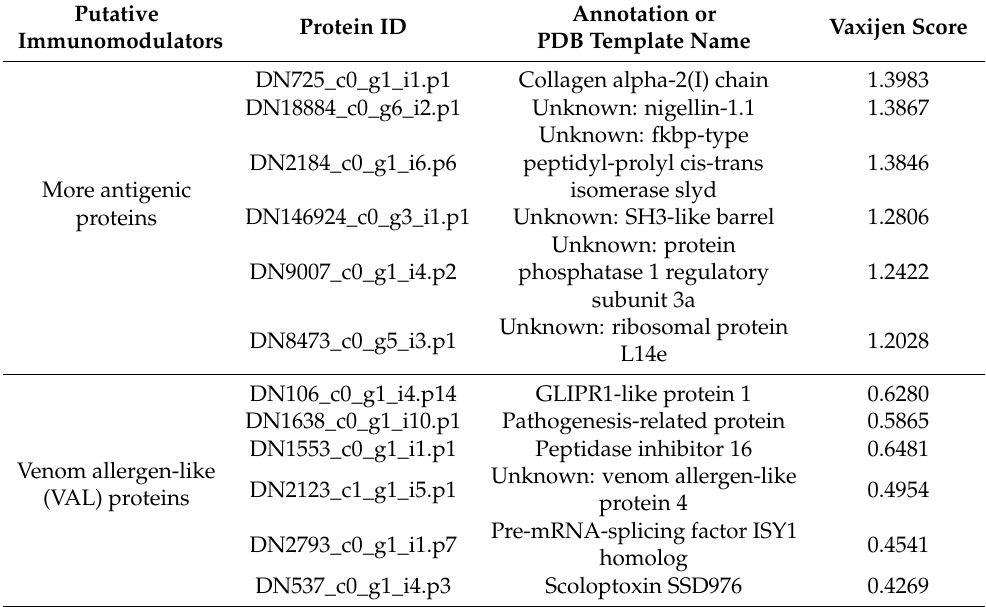
Table 1. The ES proteins of R. viridisi with potential immunomodulatory